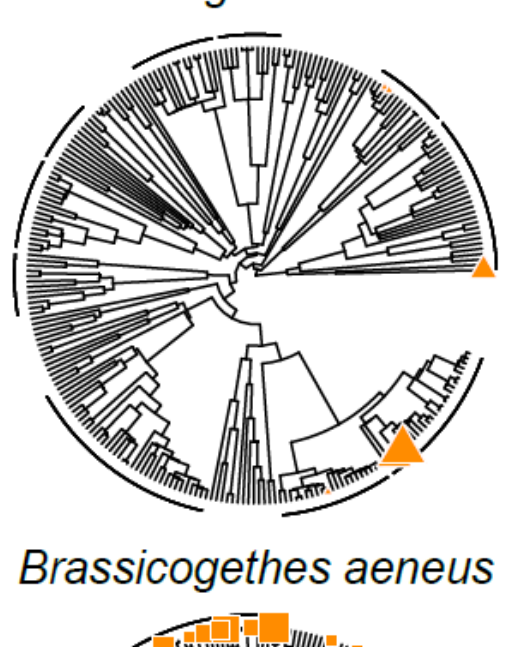
Figure 3. Distributions across the plant phylogenetic tree of the number of specimens identified (symbol size) for the three commonest species in the sample of nitidulid specimens collected (see Supplementary Material Table S1 for details). Plant clades marked by arcs match those in Figure